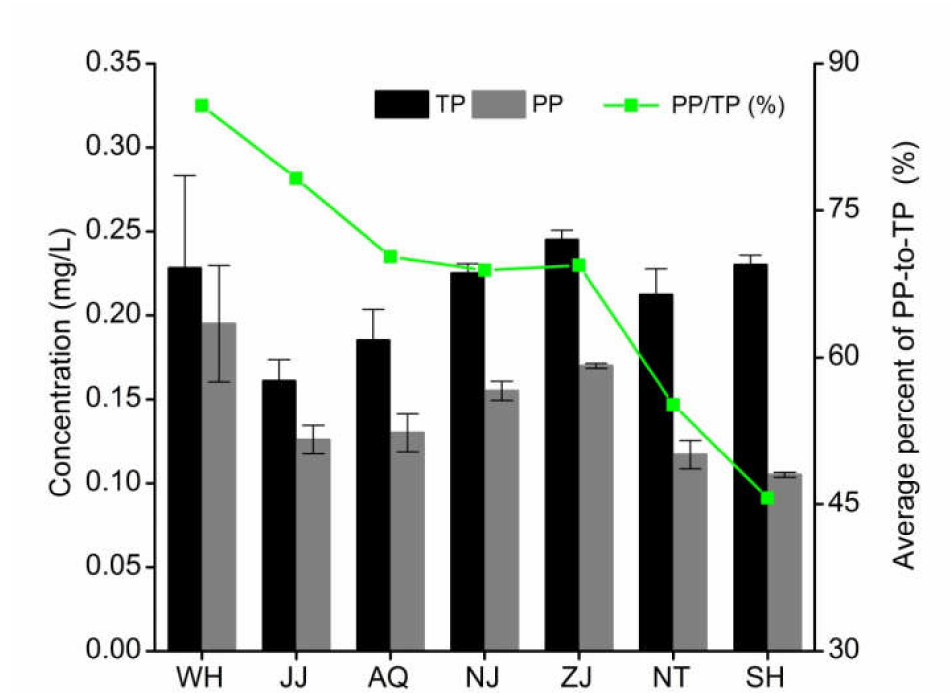
Figure 2. Distribution of total phosphorus (TP), particulate phosphorus (PP), and PP-to-TP (%) of water samples in the main urban river stretches along the middle and lower reaches of Yangtze